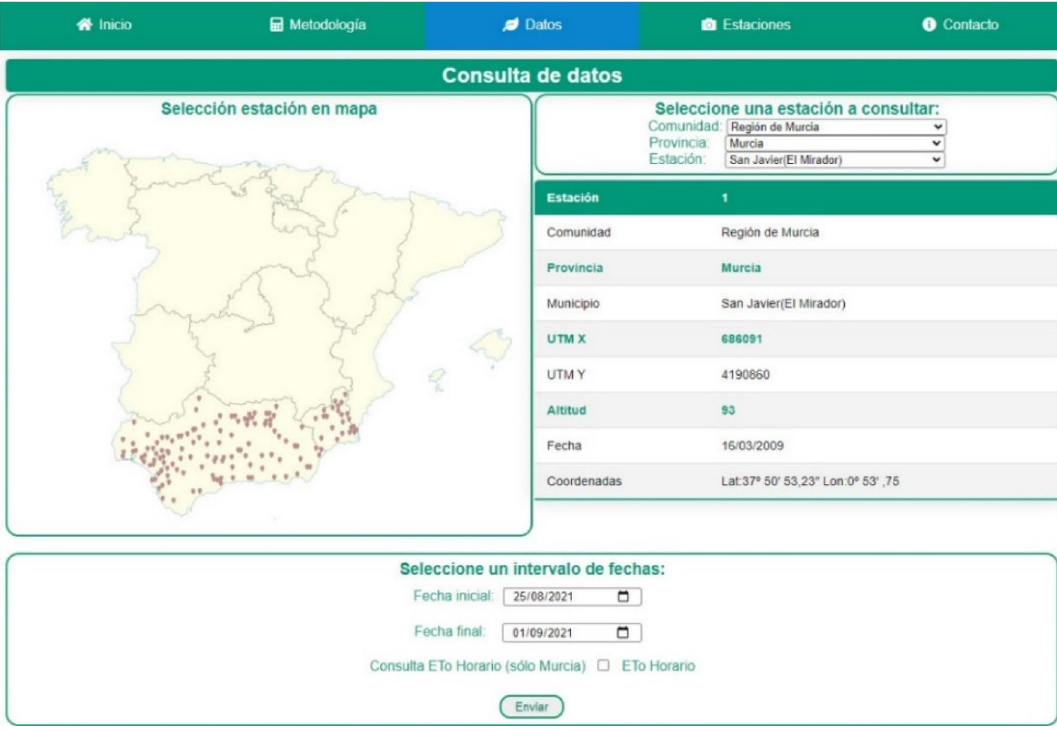
Figure 4. View of the tab to access the area where the data on the web can be consulted.